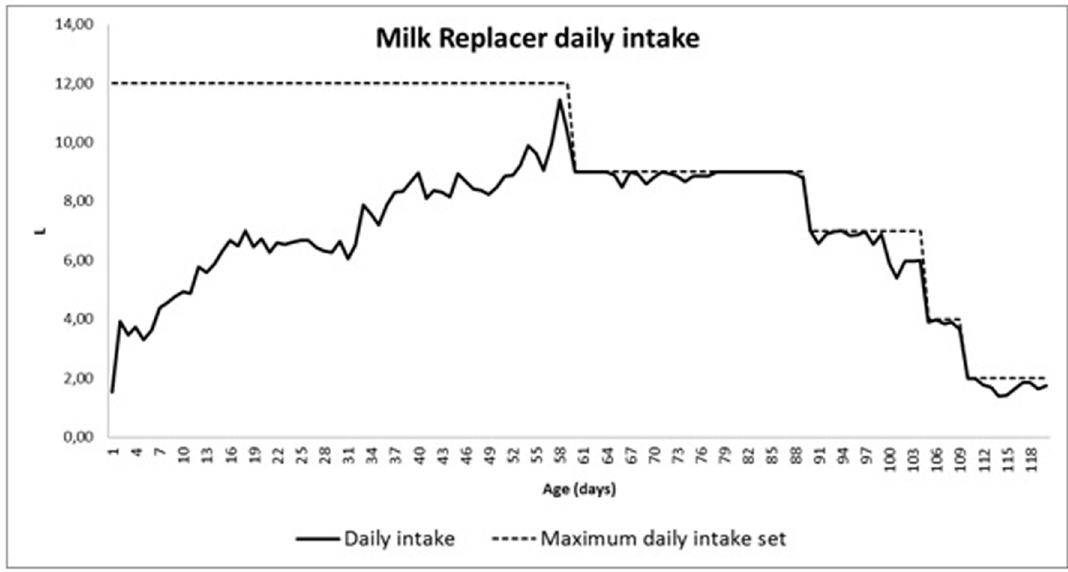
Fig 2. Maximum amount of daily available artificial milk (dashed line) and mean milk intake of donkey foals during 120 days of artificially suckling.